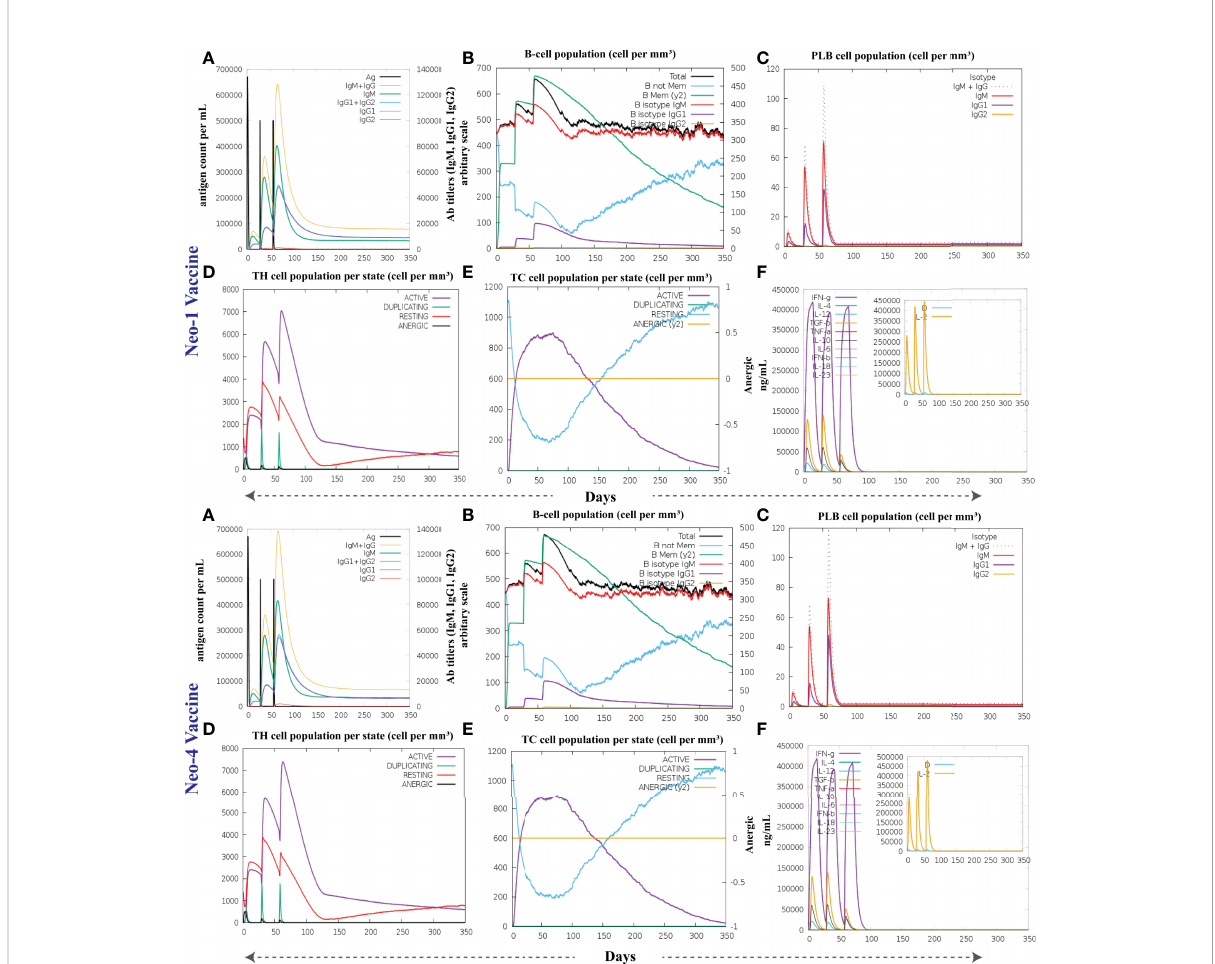
FIGURE 7 The immune response of Neo-1 and Neo-4 evaluated using C-Immsim server (A) Response of antibodies and antibodies complex to antigen (B) Total count per entity state of B-lymphocytes (C) Count of plasma B-lymphocytes (D) Total count per entity state of CD4 T helper lymphocyte (E) Total count per entity state of CD8 T-cytotoxic lymphocytes (F) cytokine concentrations and interleukin in various states shown in a smaller graph with the Simpson index shown in dotted line. In three successive immunological reactions, all units are expressed in cells/ mm 3